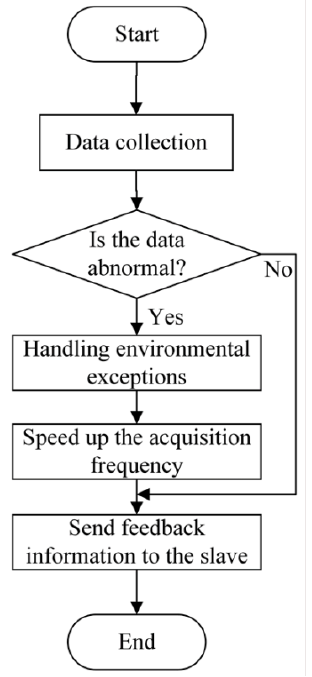
Figure 6. Sampling frequency adaptive regulation